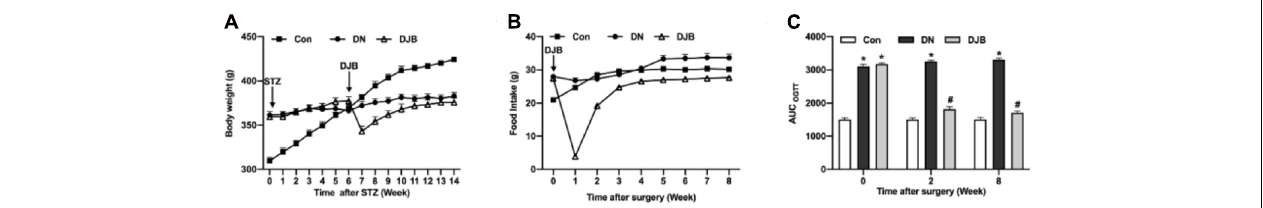
FIGURE 1 | Bariatric surgery improved glucose metabolism in diabetic rats. Detections of food intake (A) and body weights (B) in each group of rats. (C) Oral glucose tolerance tests (OGTT) were conducted every 2 weeks for a total of 8 weeks of monitoring. All data represented the mean ± SD. * p < 0.05 [compared with the control (Con) group]; # p < 0.05 [compared with the diabetic nephropathy (DN)